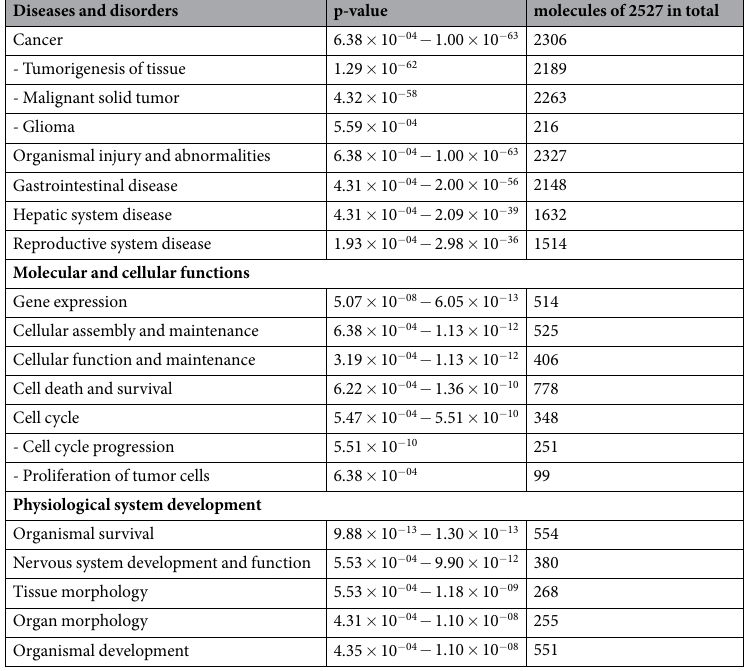
Table 3. Top diseases and functions of significant differentially expressed genes in treated vs. untreated GBM